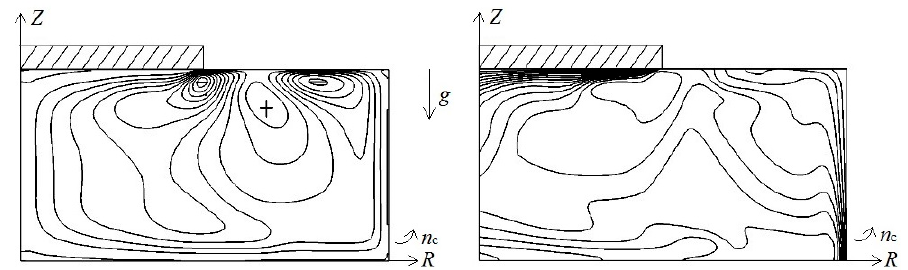
Figure 8. Overview of surface solute concentration fluctuations at Re s = 0 and Re T = 10 4 . ( a ) Re c = 9.4 ×